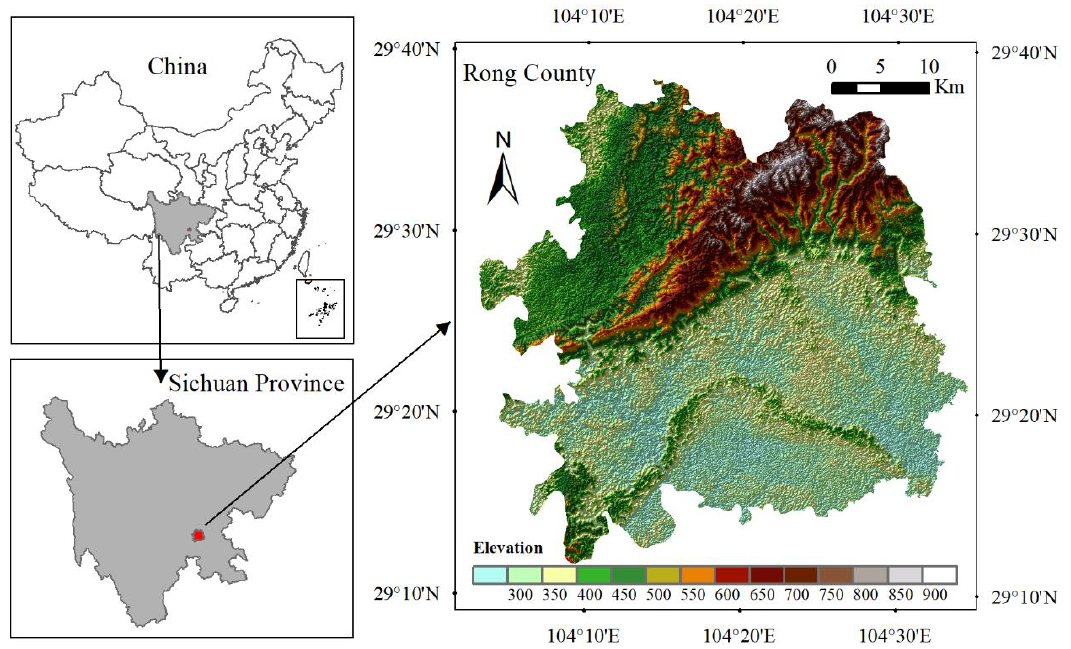
Figure 1. The location and elevation distribution of Rong County.